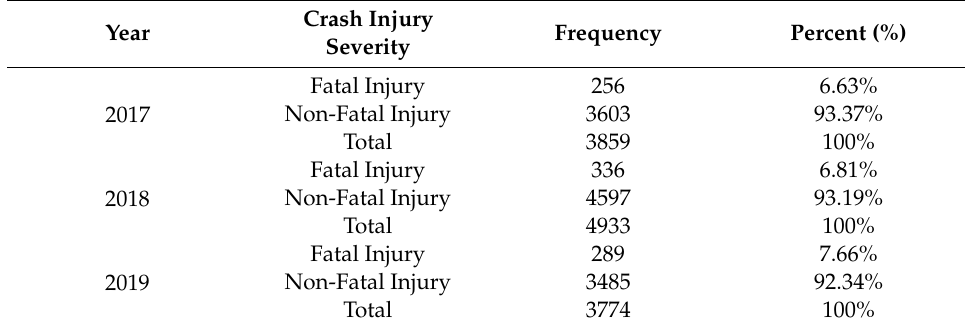
Table 2. Frequency and percentage distribution by injury severity